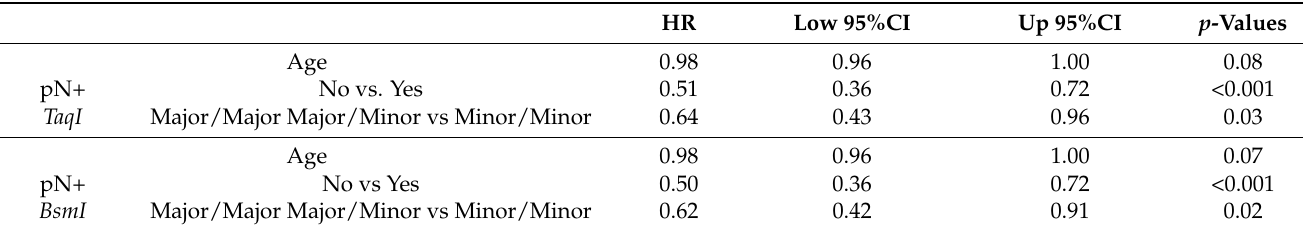
Figure 2. Kaplan and Meier curves of DFS and for BsmI and TaqI. Table 4. Results from Multivariate Cox Proportional hazard model for disease-free survival and significant VDR.